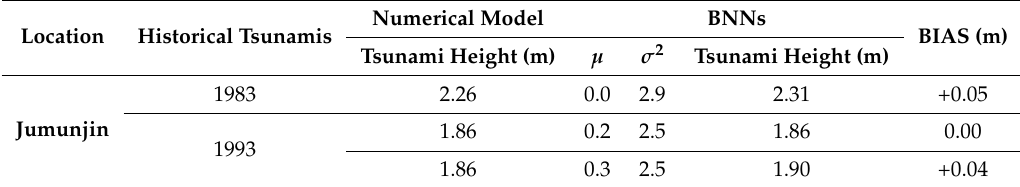
Figure 12. Testing dataset of tsunami in ( a ) 1983 and ( b ) 1993. Table 2. Comparison of numerical model and BNNs for maximum tsunami height at gage in Jumunjin port over historical tsunamis in